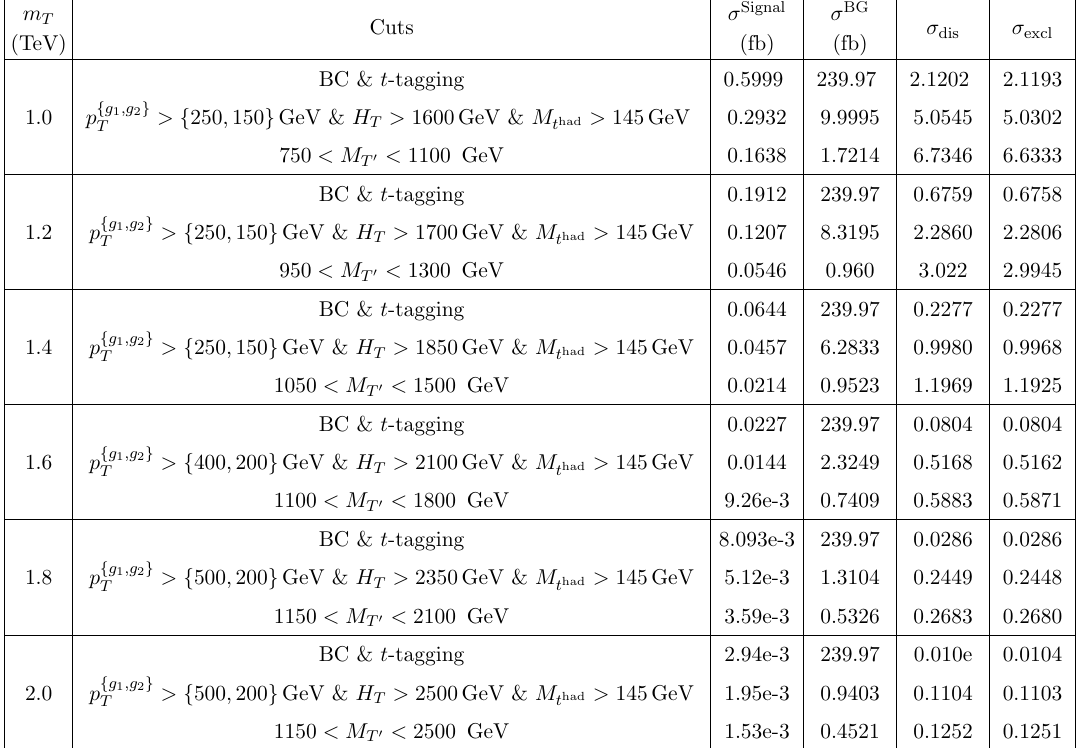
Table 6 . Cumulative cut-(cid:13)ow in the ttgg channel for both signal (spin- 1 grounds. The signi(cid:12)cance and the exclusion are calculated for a luminosity of 3000 fb (cid:0) 1 . The case with spin- 3 top partner is 2